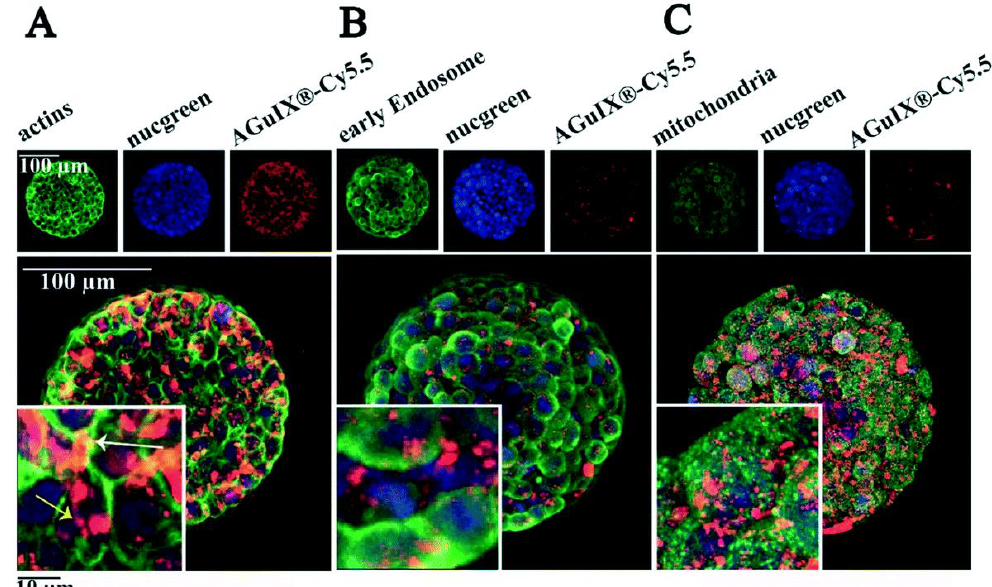
Figure 6. Penetration of polysiloxane and gadolinium chelate nanoparticles marked with fluorescent probe Cy5.5 (AGuIX -Cy5.5) in HCT-116 colorectal cancer spheroids and co-localization with different cellular structures: actin ( A ), early endosome ( B ), and mitochondria ( C ). Blue channel: cell nucleus; red channel: AGuIX -Cy5.5; green channel: phalloidin ( A ); EEA1 antibody-labeled early endosomes ( B ); AIF antibody-labeled mitochondria. Adapted with permission from [166]. Copyright 2022, Creative Commons.